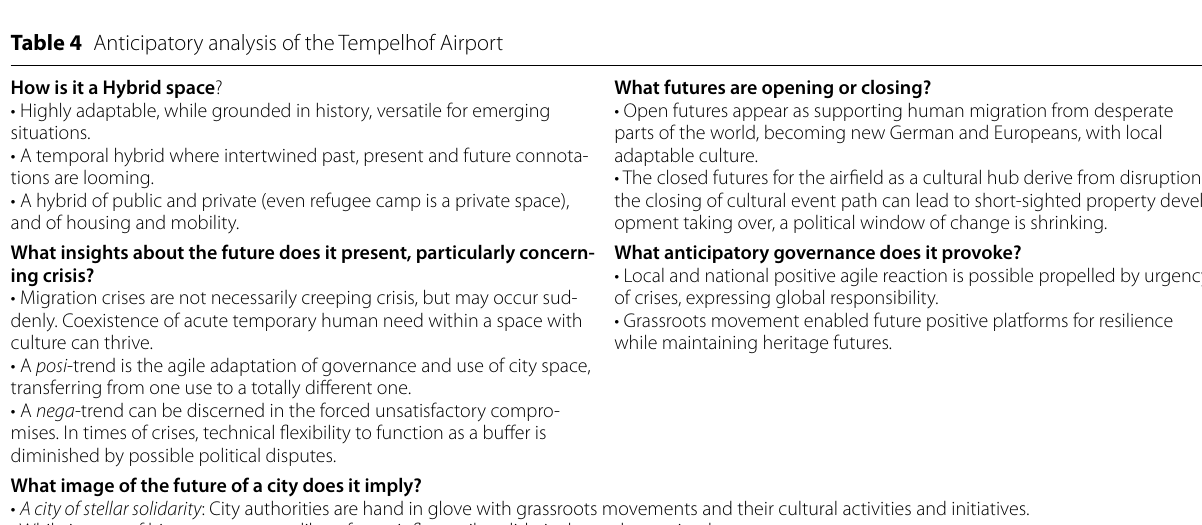
Fig. 3 Tempelhof Airport, Berlin